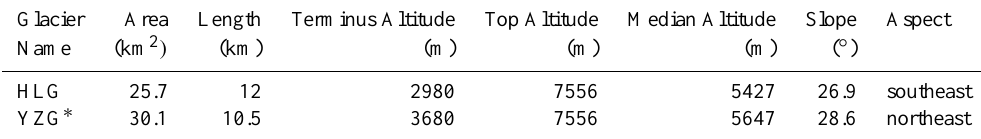
Table 8. A comparison of HLG and YZG glacier features (Pu, 1994). Glacier Area Length Terminus Altitude Top Altitude Median Altitude Slope